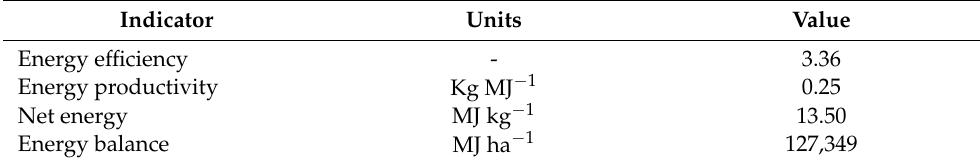
Table 11. Energy indicators of cactus biomass production in the Brazilian Northeast region.